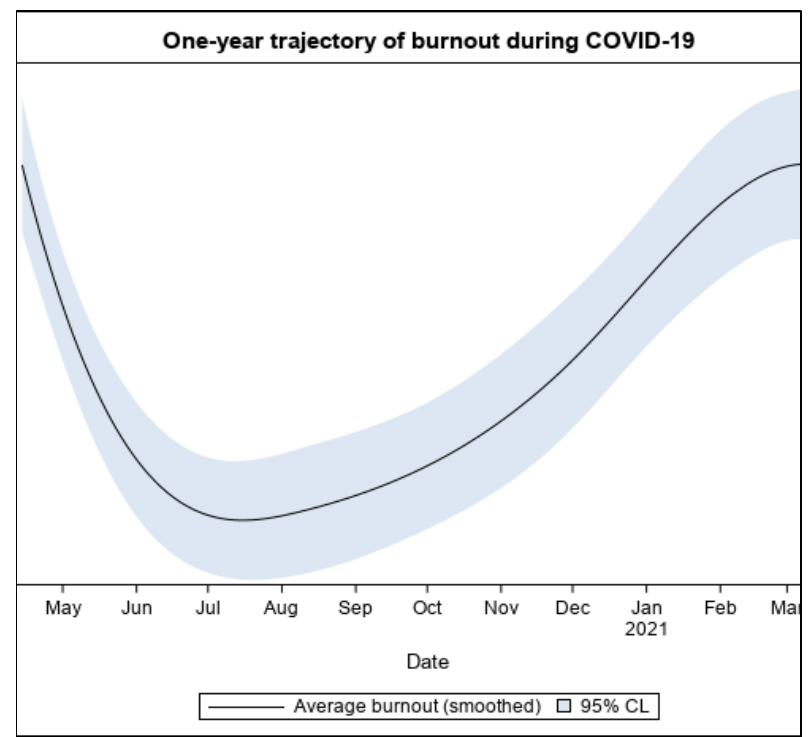
Figure 2. The one-year trajectory of burnout. Int. J. Environ. Res. Public Health 2023 , 20 , x FOR PEER REVIEW